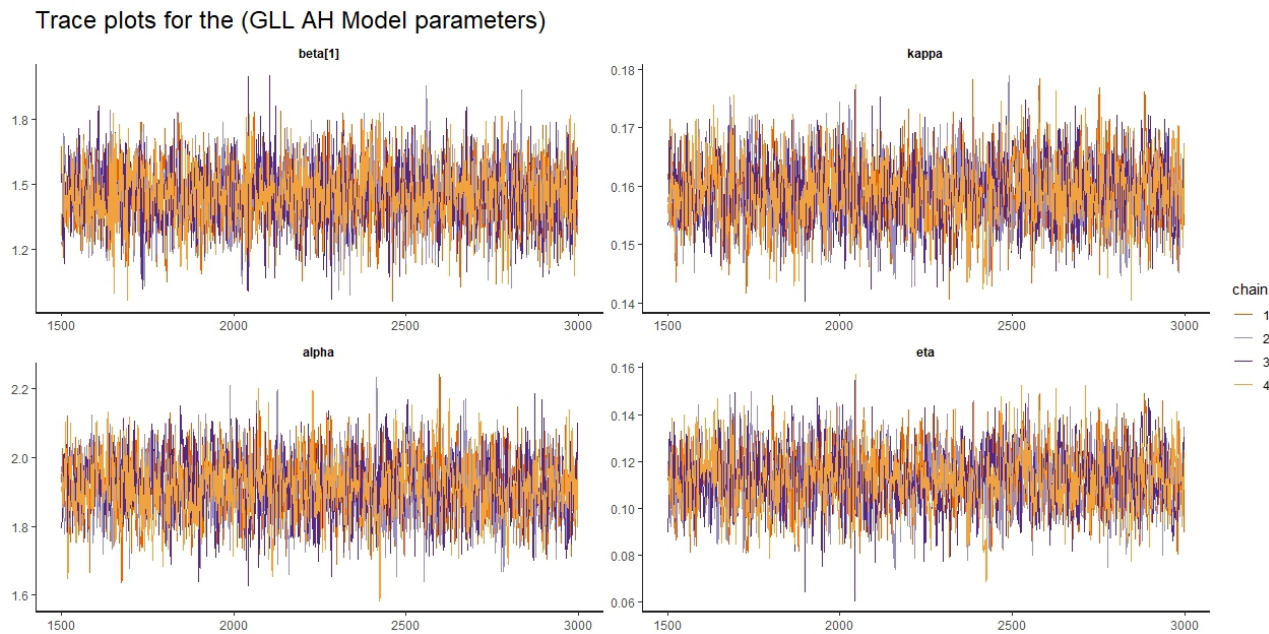
Figure 10. Trace plots for the GLL − AH model parameters.